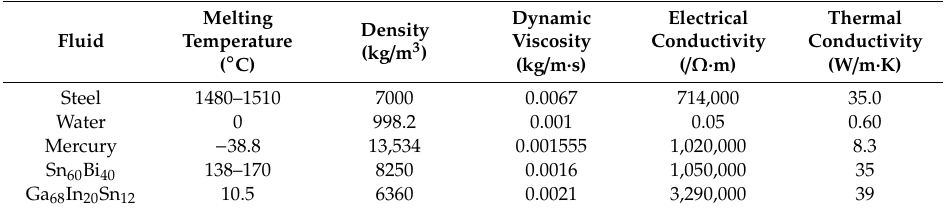
Table 1. Comparison of fluid